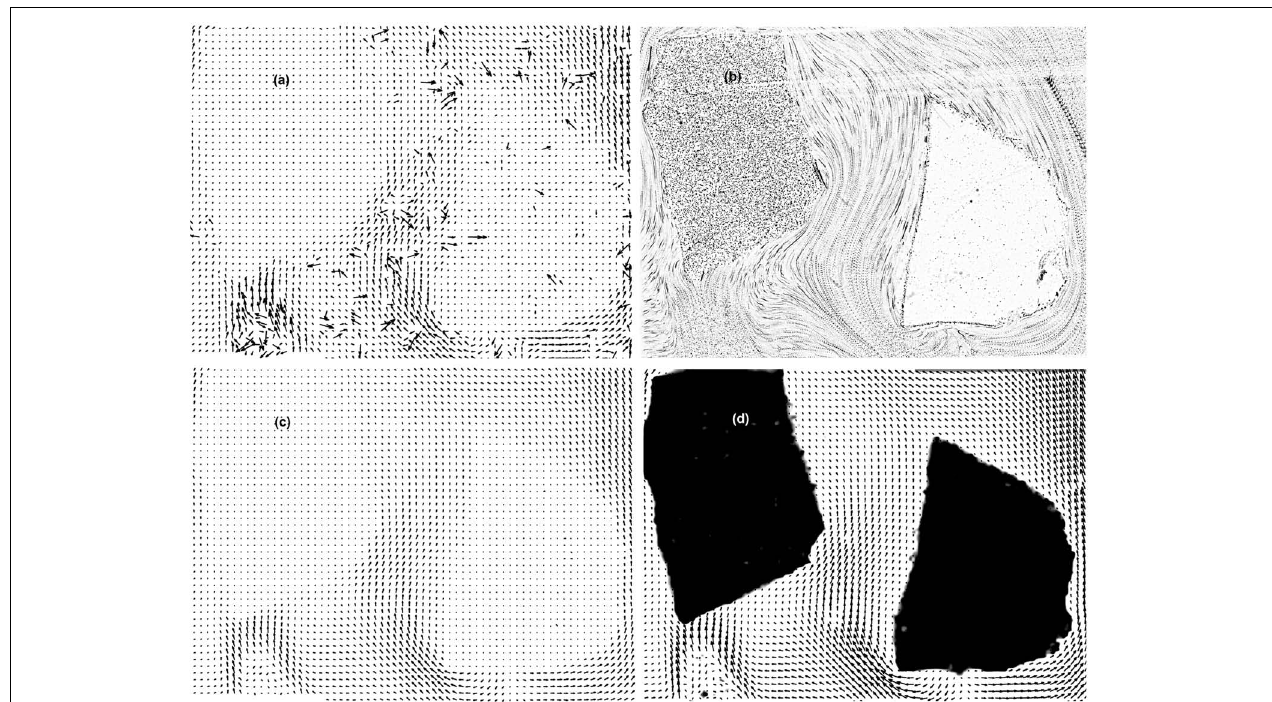
FIGURE 3 | Flow around hydrogel pieces in test cell for mode “a” experiment. (a) Instantaneous vector field. (b) Time series showing particle-pathlines. (c) Average over 100 instantaneous fields. (d) Applying near zero velocity threshold to reveal outline of pieces (method 2 for finding the solid-liquid boundary). A velocity vector with length of one grid spacing had a velocity of 4.6 mm/s. The approximate vertical velocity in the cell away from the grains was 5 mm/s. All vector plots show a vector for every other interrogation cell